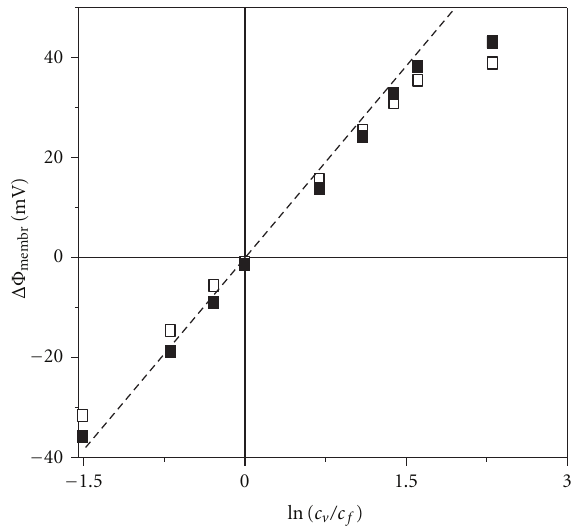
Figure 8: Membrane potentials versus solution concentrations ratio for Nafion-112 ( (cid:5) ) and Naf-112/DTA + ( (cid:4) ) in contact with HCl